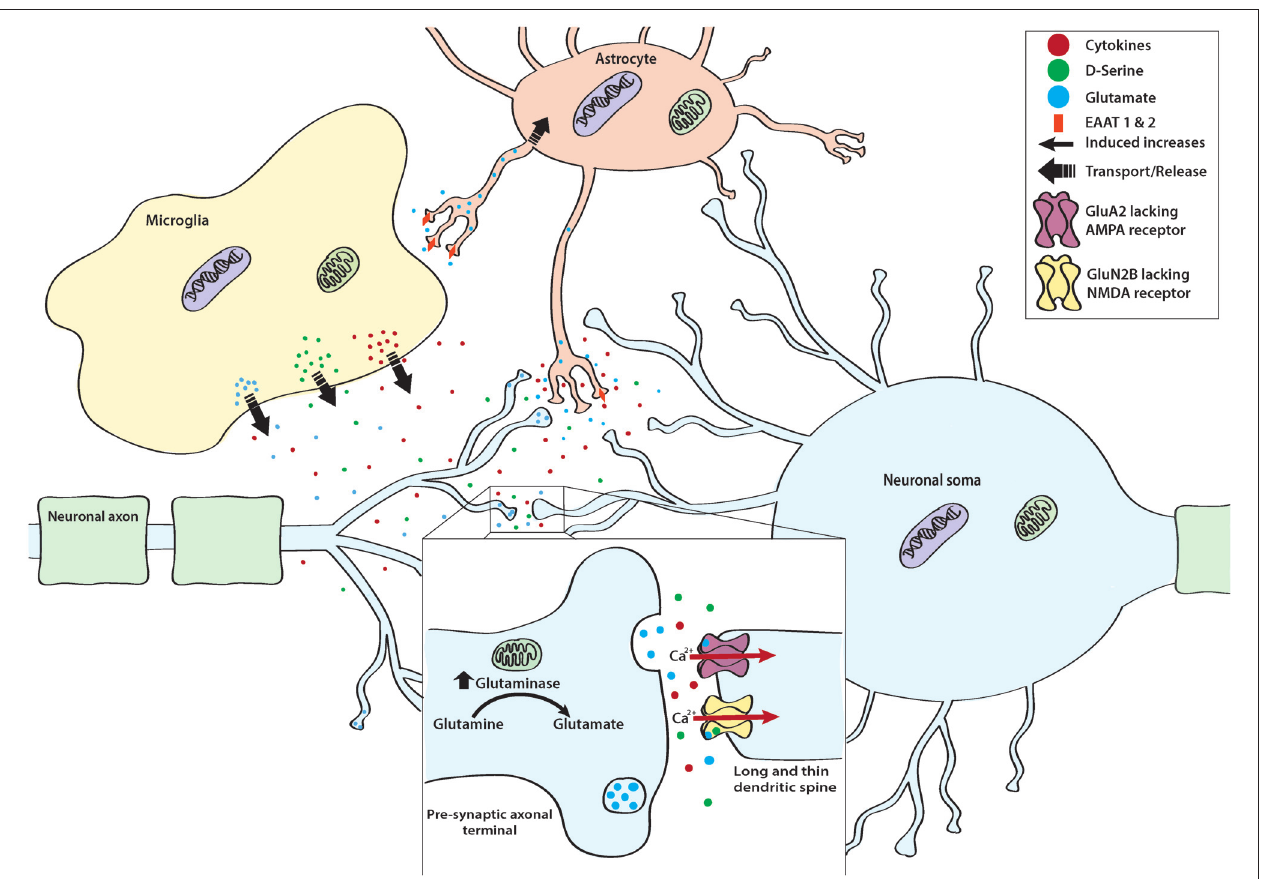
FIGURE 2 | Mechanisms of stress-induced cytotoxicity. In addition to releasing cytokines, Ml type proinflammatory microglia release a variety of neurotransmitters, co-agonists, and neuromodulators such as glutamate and its co-agonist D-serine. Normally, excess glutamate is taken up by excitatory amino acid transporter (EAAT) 1 and 2 found on astrocytic processes. However, in proinflammatory conditions and in the presence of excess glutamate, EAAT 1 and 2 are down regulated, thereby resulting in excess glutamate within the synaptic cleft. Importantly, neurons also contribute to stress-induced enhancements of glutamatergic tone. This is thought to occur as stress exposure enhances mitochondrial glutaminase, the enzyme responsible for converting glutamine to glutamate. In addition to enhancing excitatory tone, stress also sensitizes neurons to the excitatory effect of glutamate. Specifically, stress promotes the expression of GluA2 lacking α -amino-3-hydroxy-5-methyl-4-isoxazolepropionic acid (AMPA) receptors and GLUN2B lacking NMDA receptors. These receptor subtypes allow for calcium (Ca 2 + ) to freely pass into the cell thereby enhancing the depolarizing effect of glutamate. This cumulative increase in excitatory tone is particularly detrimental for dendritic spines that exhibit a long and thin morphology, as these spines are more sensitive to the degenerative effects induced by glutamatergic excitotoxicity.